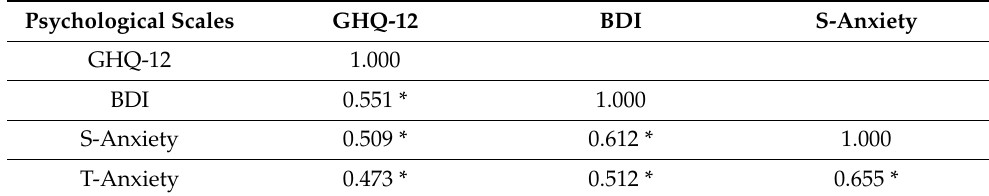
Table 4. Correlation coefficients among GHQ-12, BDI, and